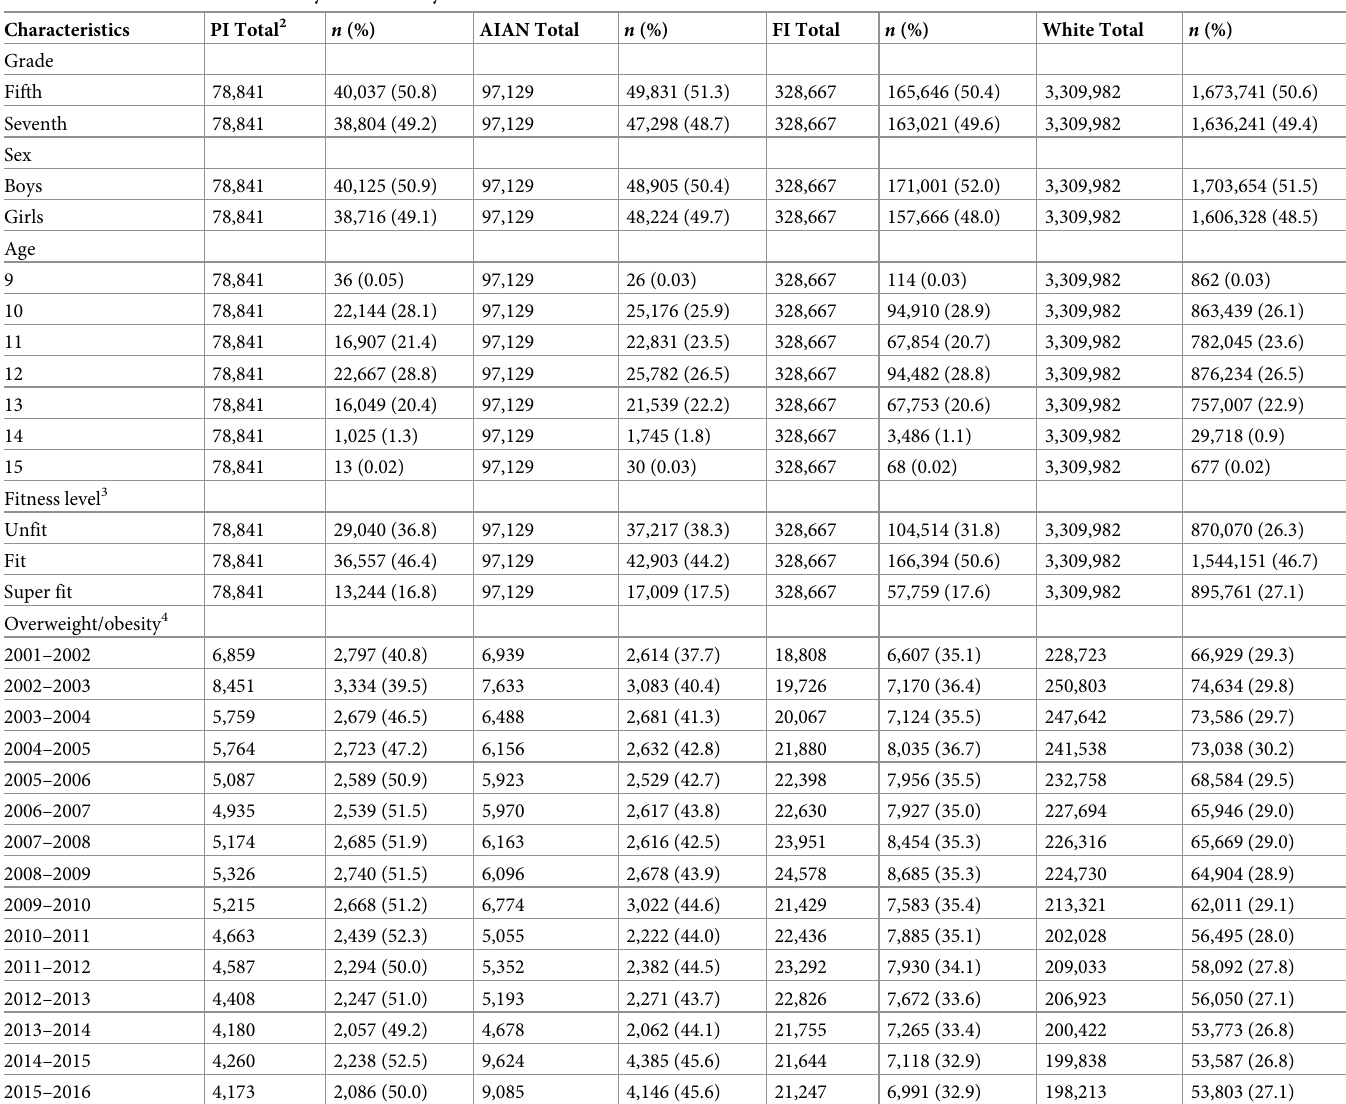
Table 1. Characteristics of students by race/ethnicity 1